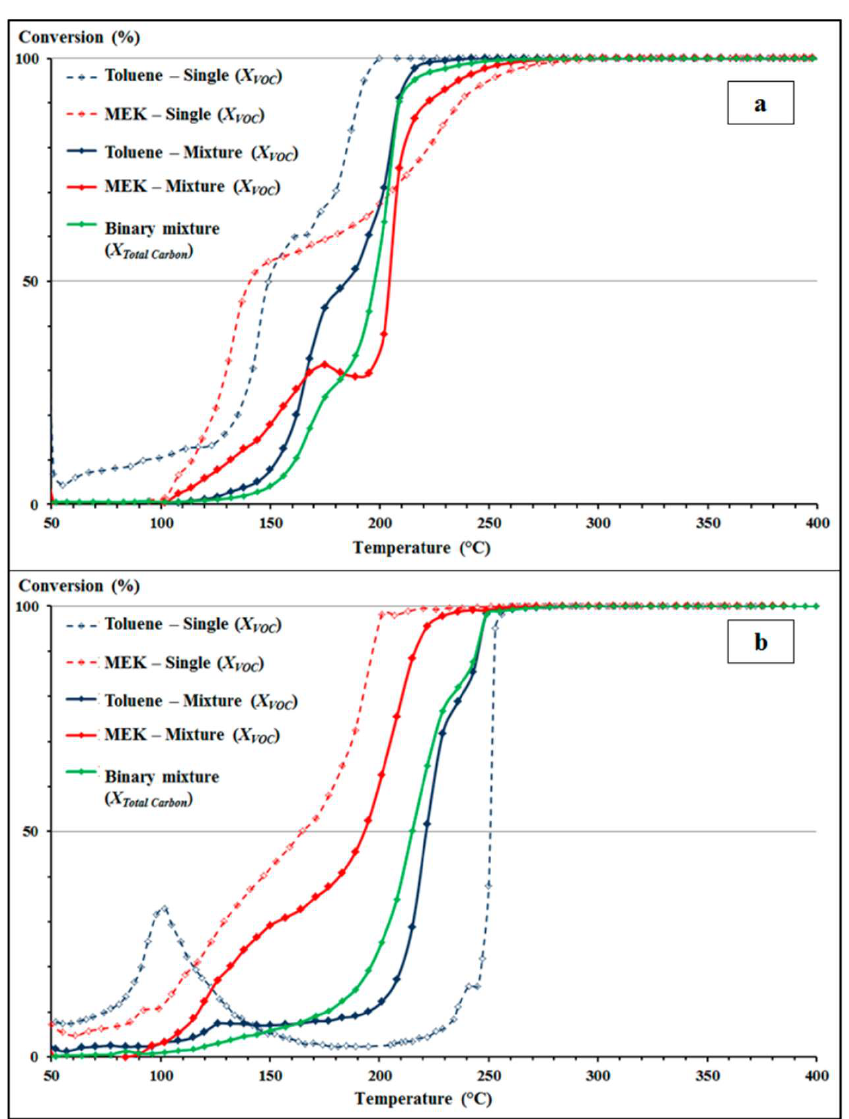
Figure 2. Light-off curves of VOCs alone, in mixture and binary mixture for ( a ) Pd/ γ -Al 2 O 3 and ( b ) CoAlCeO catalyst from [13].